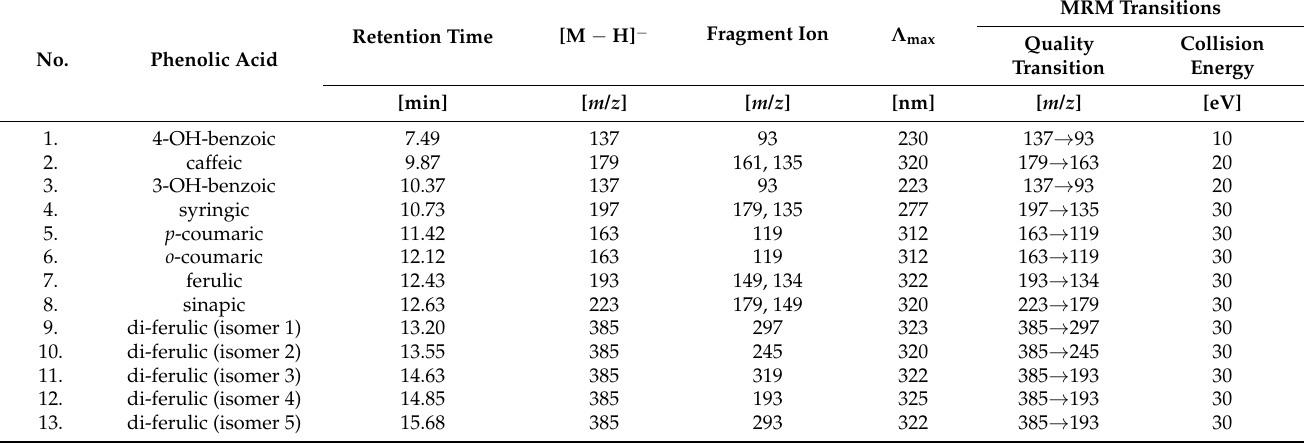
Table 1. Separation parameters of phenolic acid standards by UPLC/MS